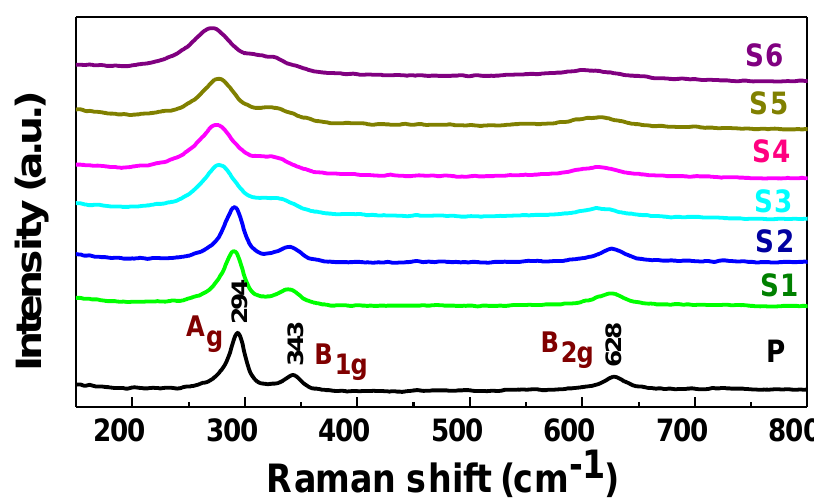
Figure 3. Raman spectra of pure and Zn-doped CuO films.